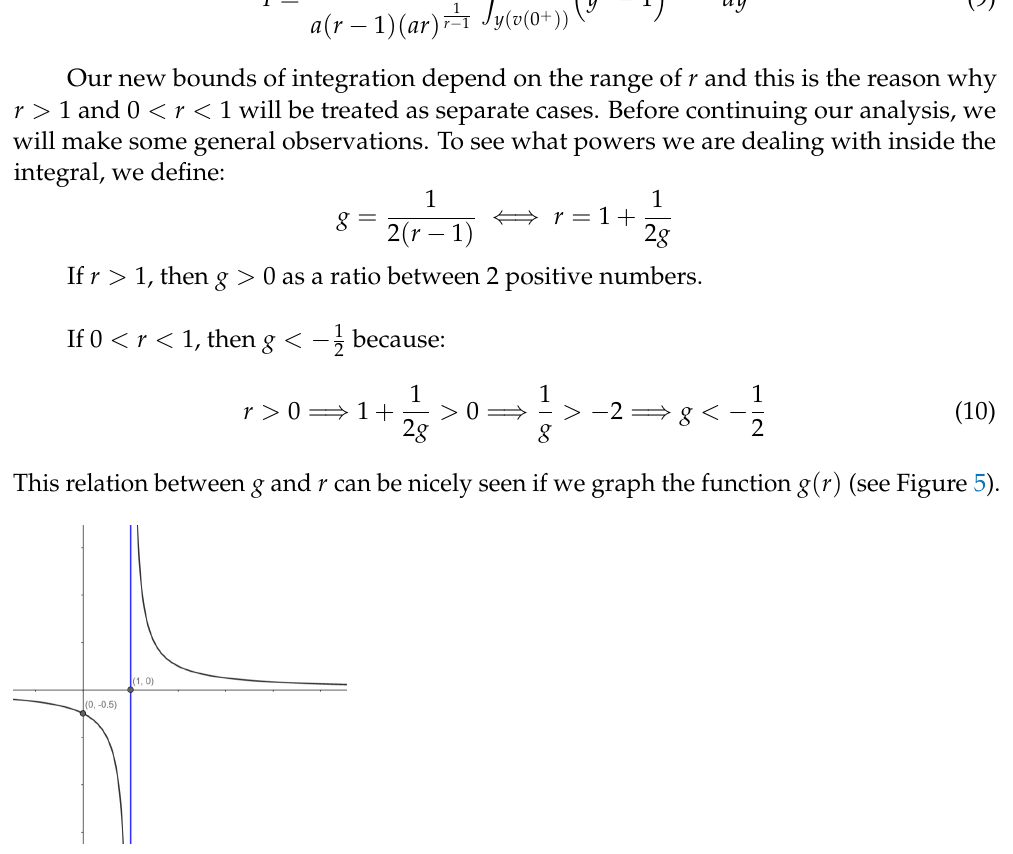
Figure 5. A plot of the function g ( r ) = 1